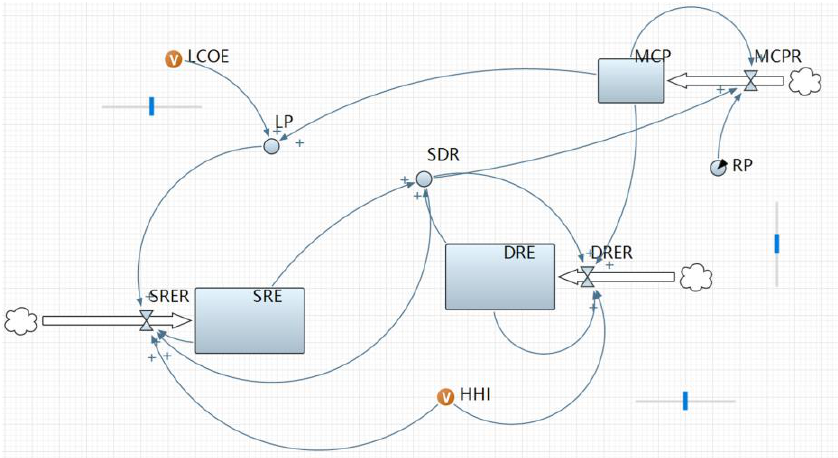
Figure 2. System-flow-diagram interface based on SDS built in AnyLogic software.